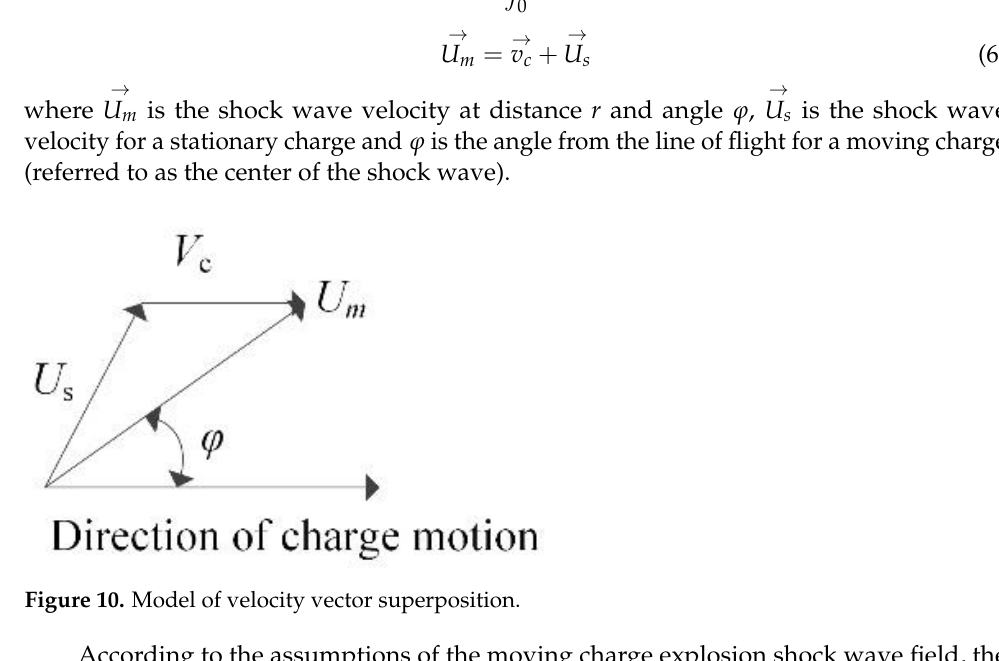
The distance r c that the center has traveled (in the direction of original charge motion) from the point of detonation at any time t is given by Equation (5). The velocity of the surface of the spherical blast wave produced by the moving charge is shown in Figure 10 and Equation (6).